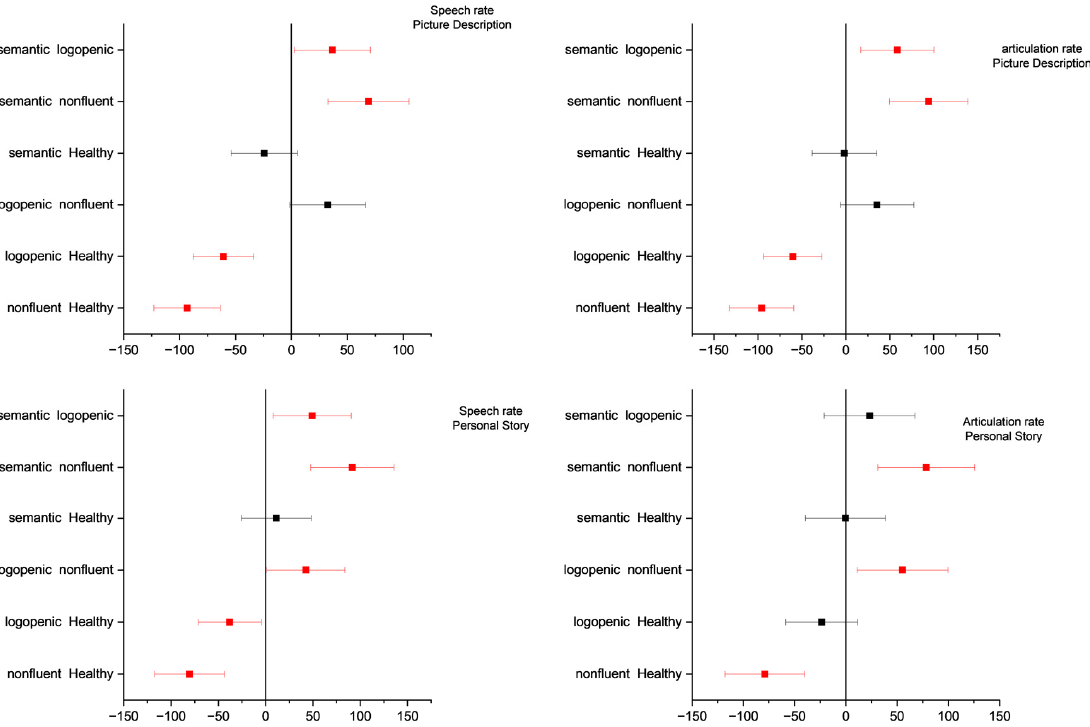
Figure 4. Tukey’s significance test of the one-way ANOVA results for the speech and articulation rate data of each type of diagnosis. First row: picture description task. Second row: personal story narration. Significance level: 0.05.